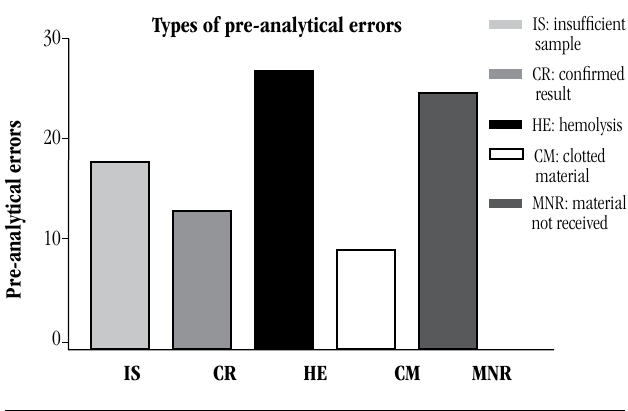
Types of pre-analytical